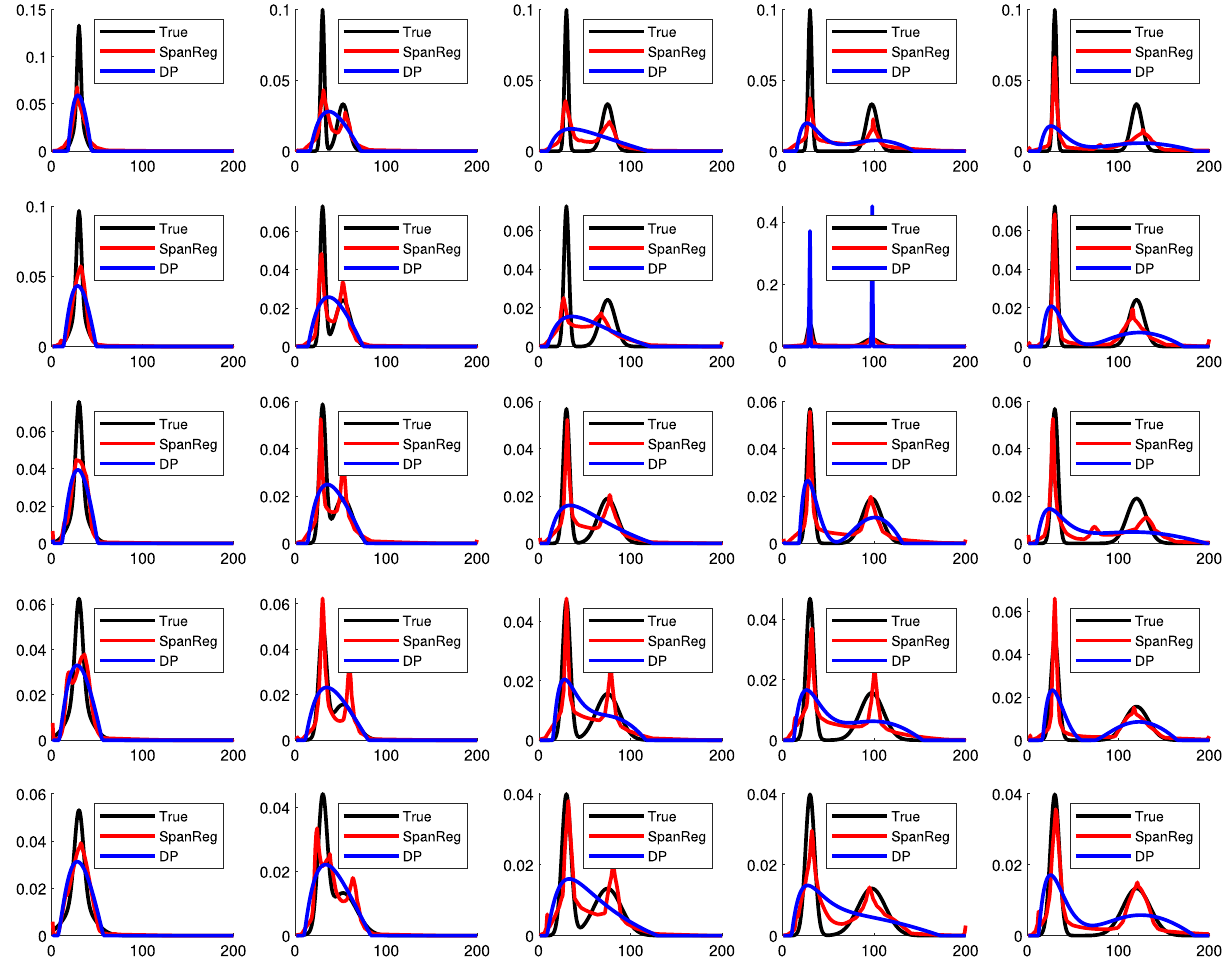
Figure 1. Comparison of the recovered distributions from SpanReg (red) and the discrepancy principle (blue) with the true underlying distributions (black). Each panel represents a T 2 distribution consisting of the sum of two Gaussian functions as in Eq. (14). The value of σ 1 , the standard deviation of the left-most component, increases from 2 ms (top row) to 5 ms (bottom row) with σ 2 = 3 σ 1 throughout. Across each row, the ratio of peak separation (RPS) increases from 1 (left-most column) to 4 (right-most column), with the left-most distribution centered at µ = 35